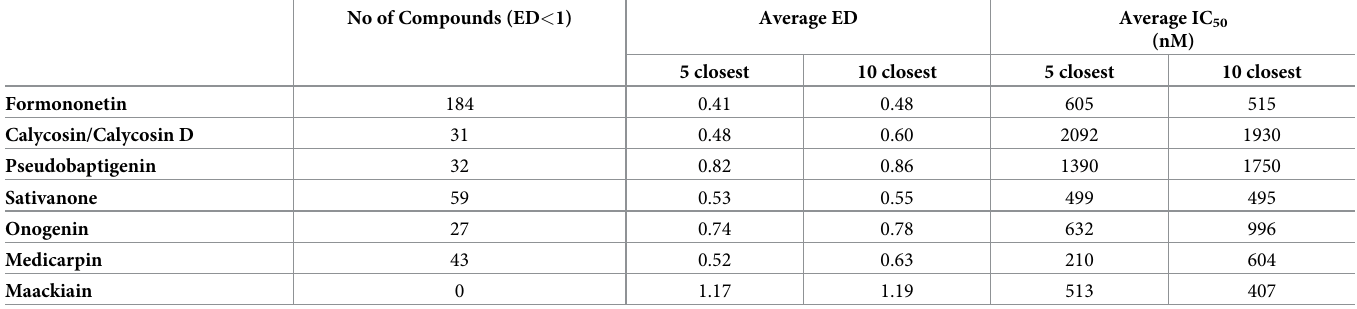
Table 3. The number of compounds in the proximity of the target molecules, and the average MAO-B inhibitory IC 50 values of the 10 and 5 closest structures in chemical space (see details in supplementary). No of Compounds (ED < 1)